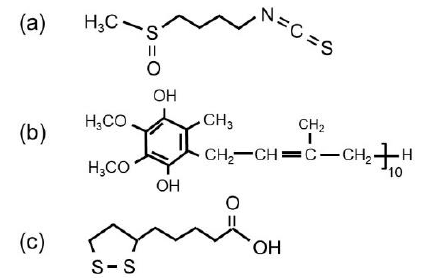
Figure 1. Schematic representation of the chemical composition of broccoli extract. Chemical structure of ( a ) sulforaphane, ( b ) vitamin coenzyme Q10 and ( c ) α-lipoic acid.